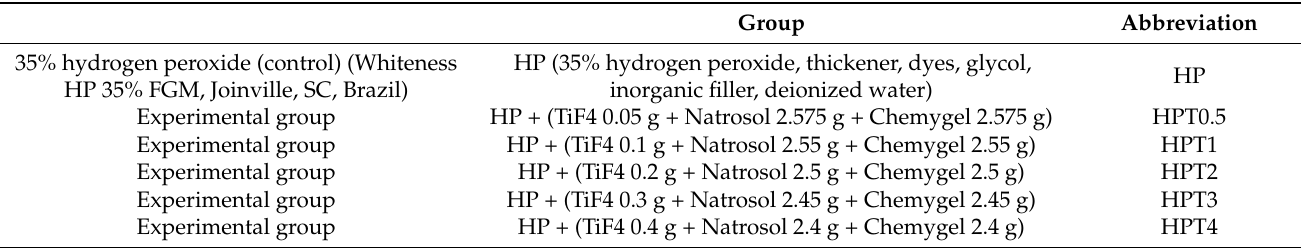
Table 1. Treatment groups and